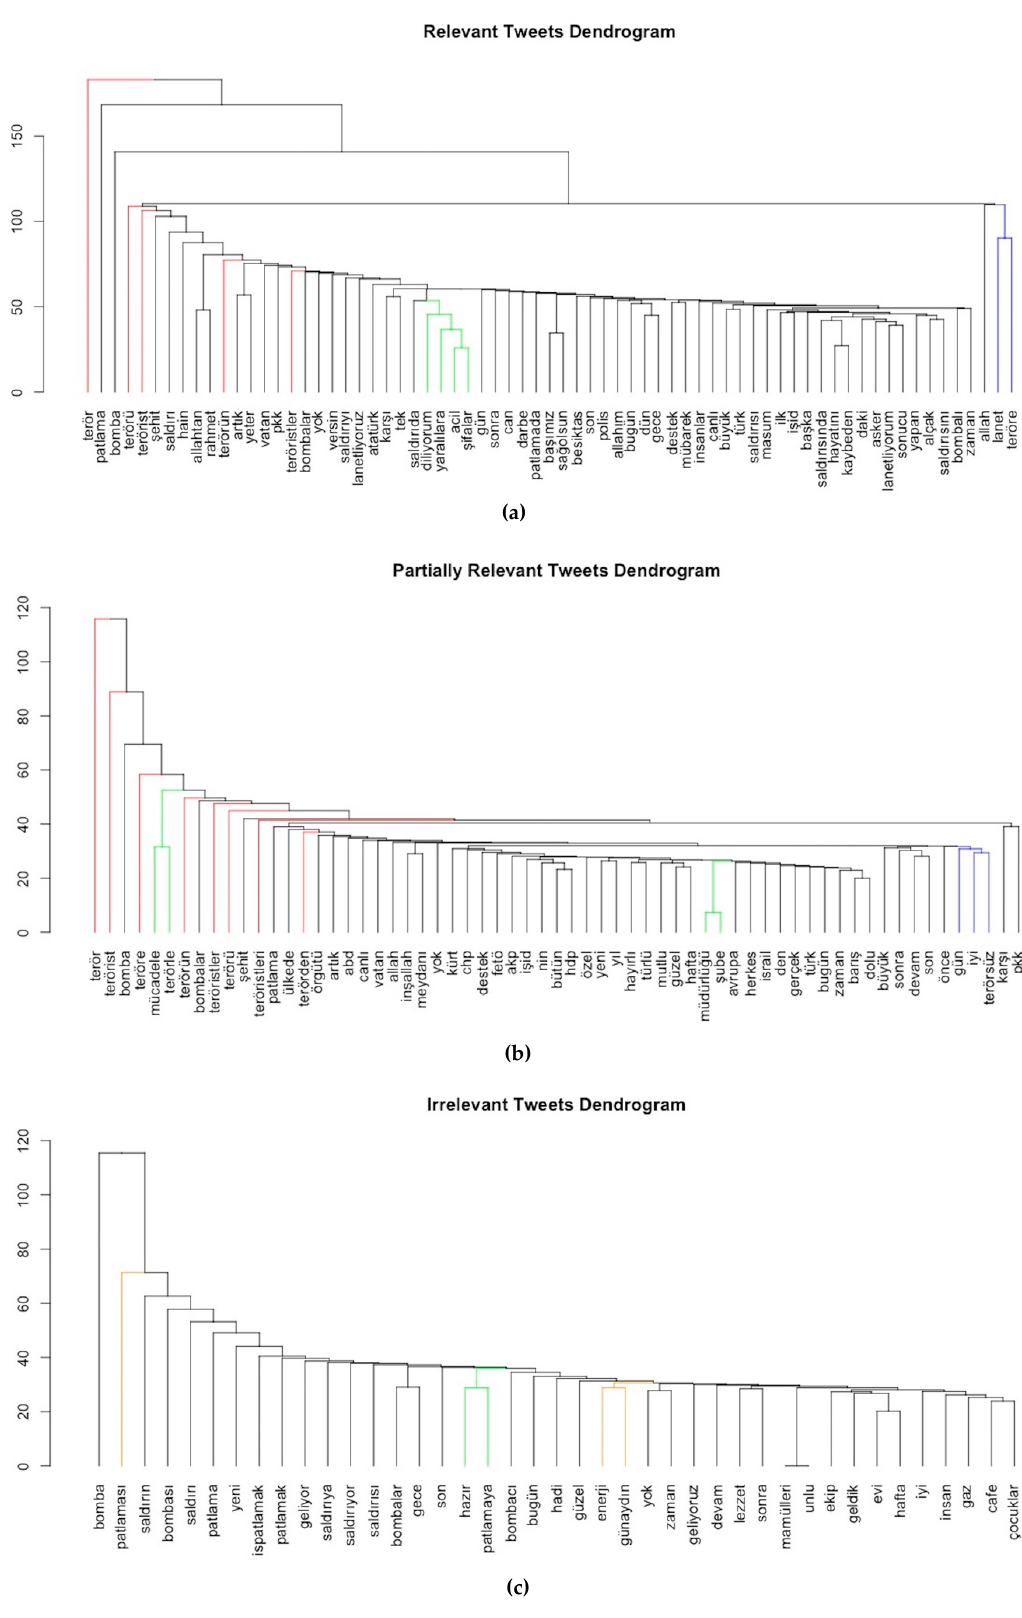
Figure 10. Word Association Dendrograms for (a) relevant (RL), (b) partially relevant (PR), and (c) irrelevant (IR) tweets.